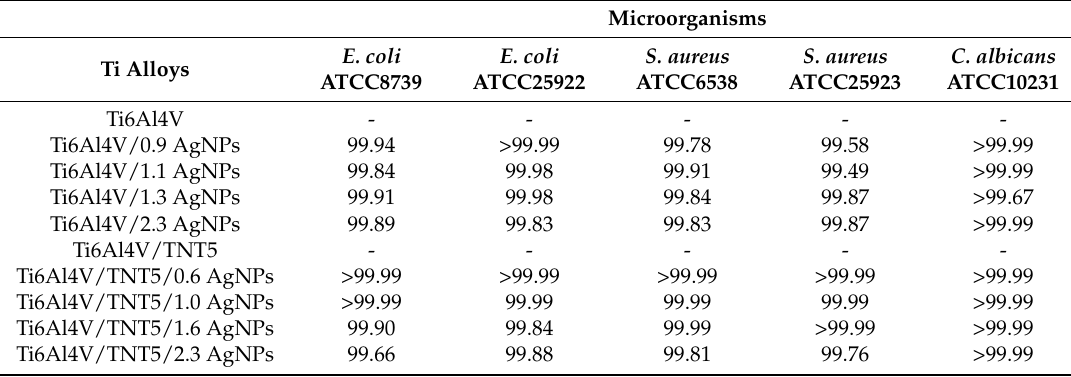
Table 5. The reduction of microbial growth (%) in PBS after the use of Ti6Al4V/AgNPs and Ti6Al4V/TNT5/AgNPs alloys for 28 days of ion